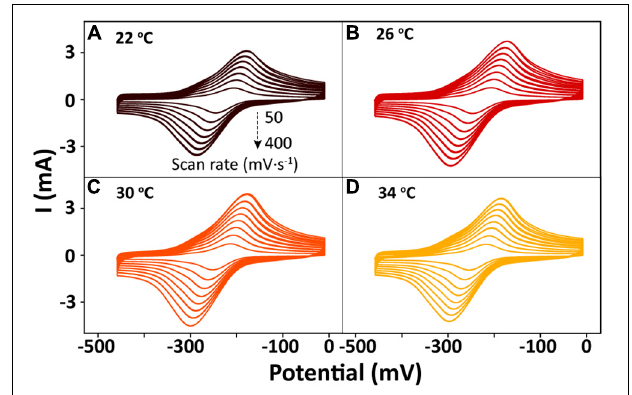
FIGURE 8 | Cyclic voltammetry results for AQS at different scan rates (50–400 mV s − 1 ) and temperatures: (A) 22 ◦ C, (B) 26 ◦ C, (C) 30 ◦ C, and (D) 34 ◦